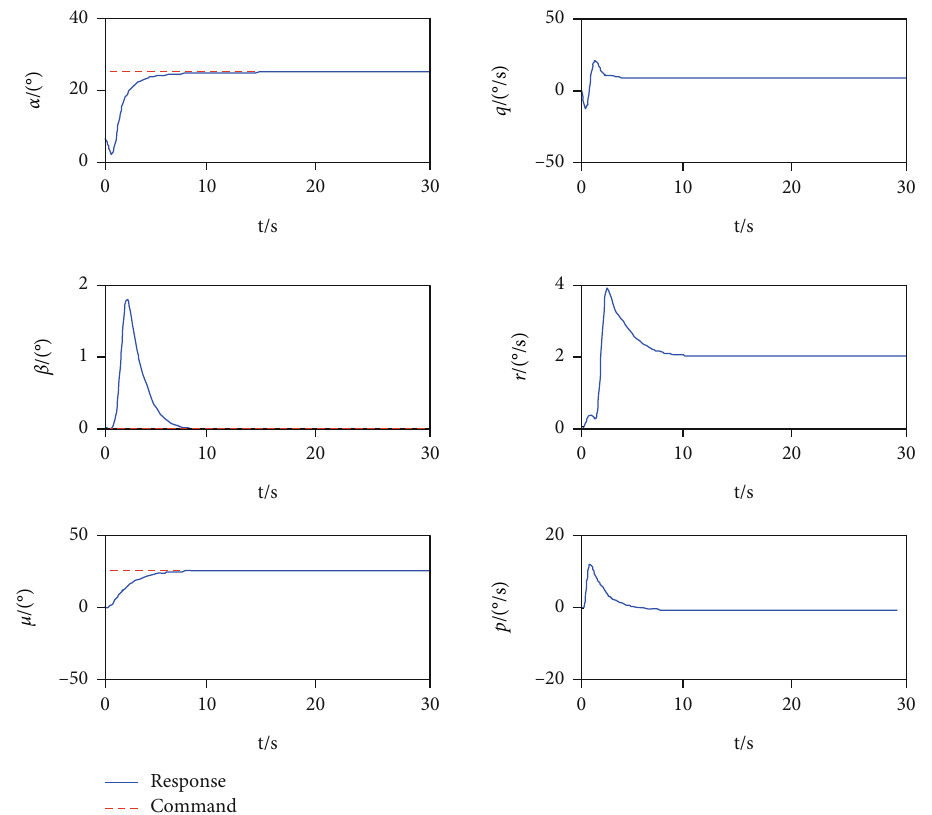
Figure 8: The state response of three-axis maneuver against fault mode